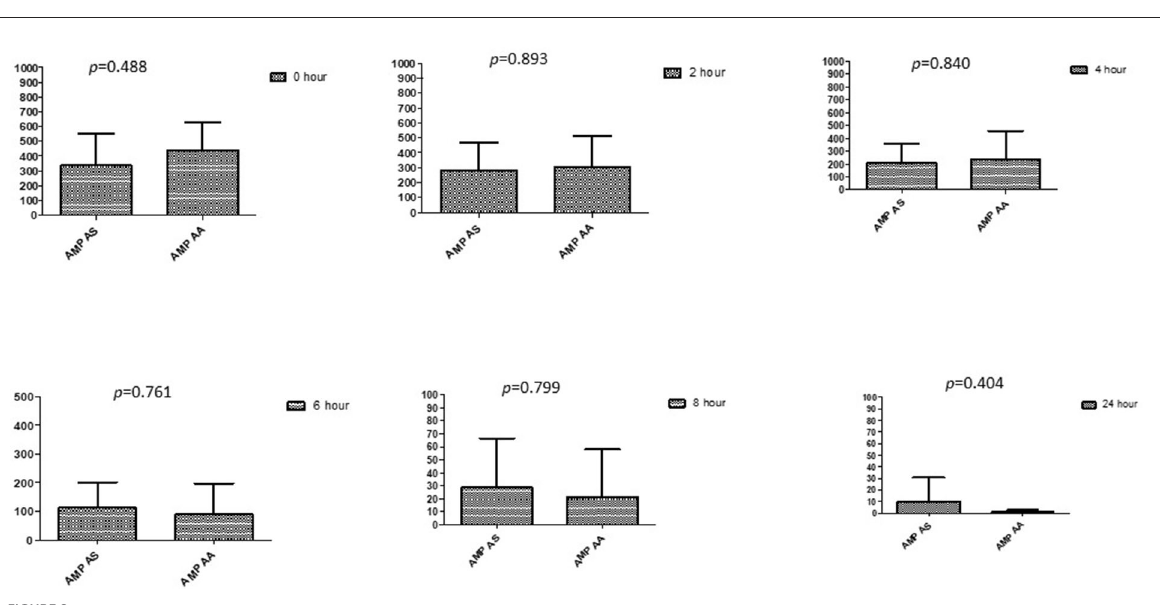
FIGURE8 Comparison of ampicillin’s minimum inhibitory concentrations ( µ g/mL) when combined with AA and AS on E. coli. AMP-AS, Ampicillin combined with AS; AMP-AA, Ampicillin combined with AA; p < 0.05 indicate a significant difference among MICs of antibiotic combined with AS and